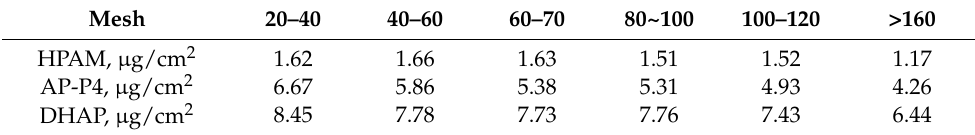
Table 5. Adsorption capacity of various fractions of quartz sand